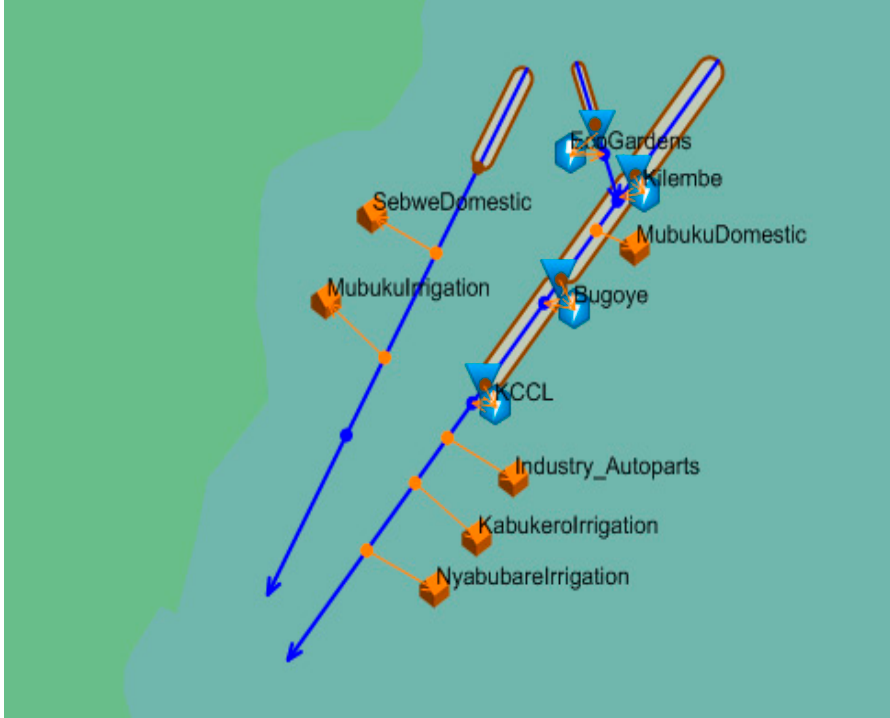
Figure 2 . Schematic diagram for Mubuku-Sebwe sub-catchments . Figure 2. Schematic diagram for Mubuku-Sebwe